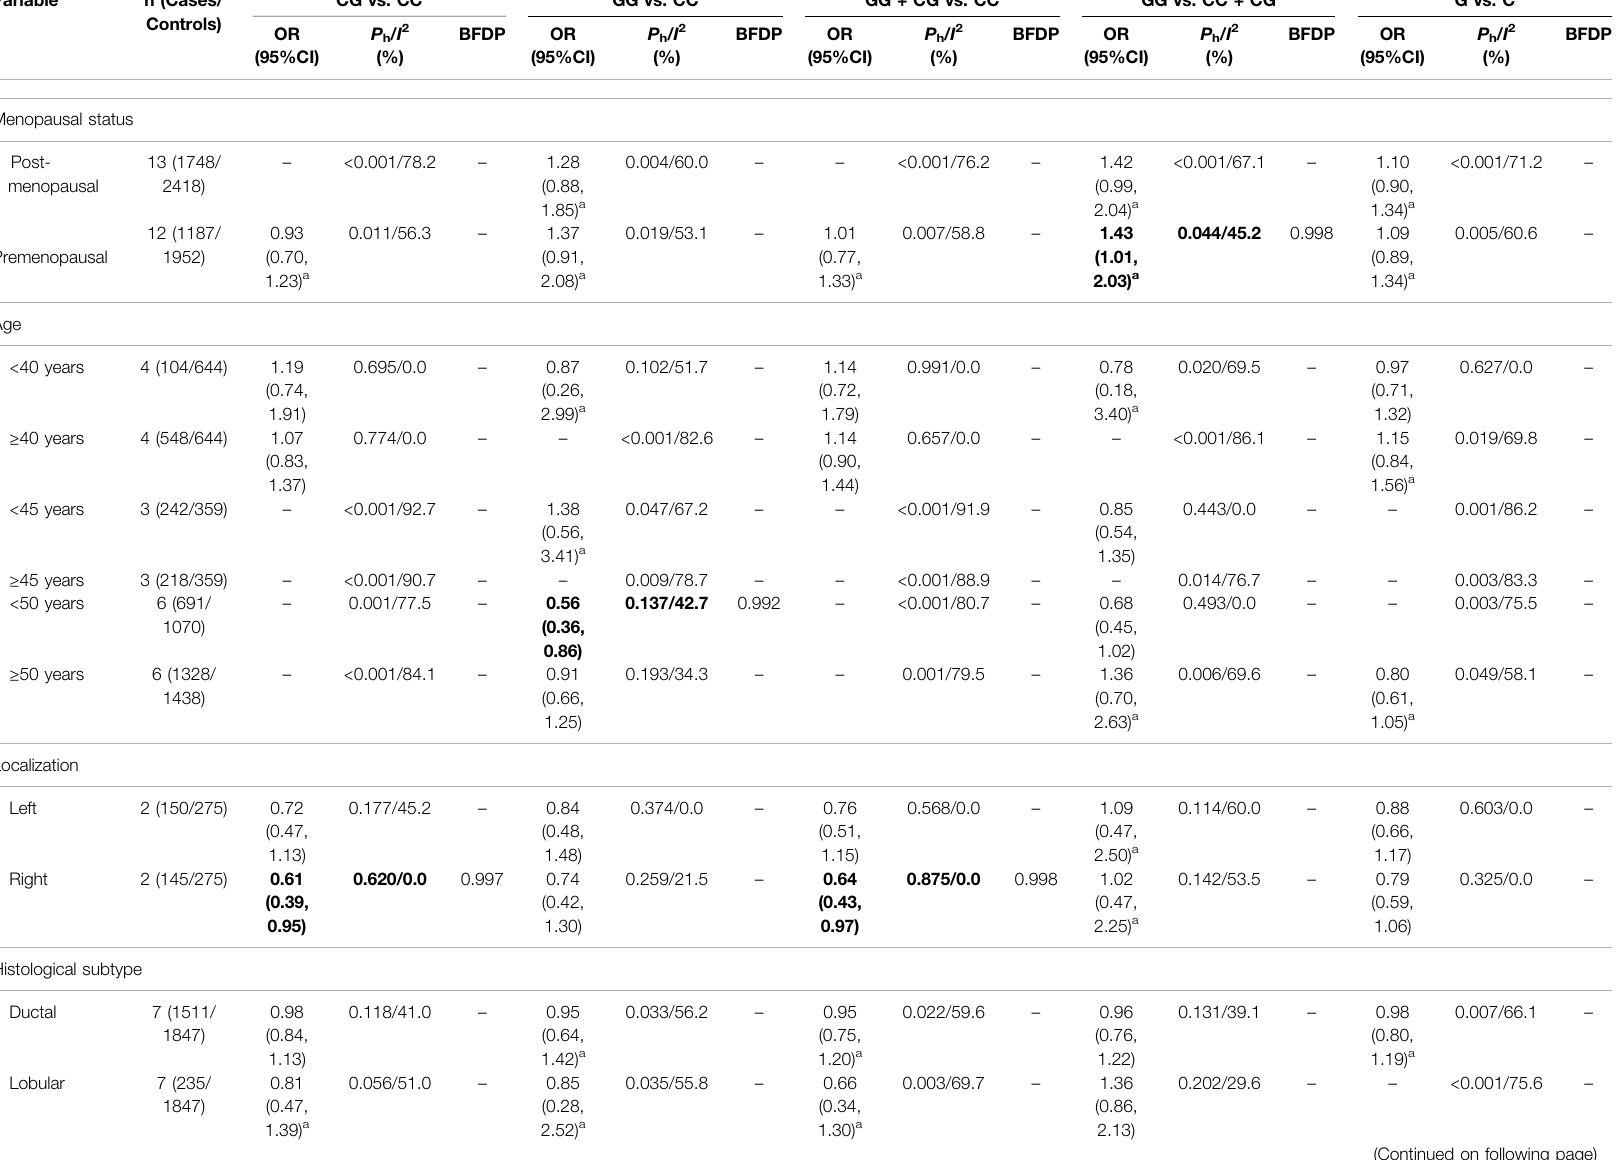
TABLE 2 | ( Continued ) Pooled results on the association between the TP53 codon 72 (rs1042522) polymorphism and BC